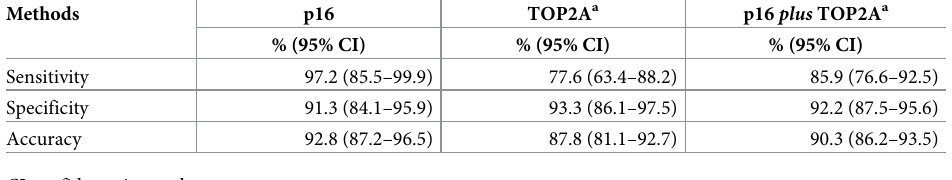
Table 4. Diagnostic values of p16 and TOP2A immunohistochemistry in differentiating cancerous cervical lesions from benign and precancerous cervical lesions among women seeking cervical cancer care at Kilimanjaro Chris- tian Medical Centre (n =